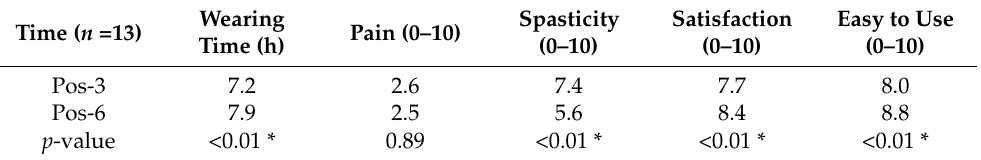
Table 4. Subjective reported wearing time, pain, spasticity, level of satisfaction, and ease of self-wear in the experimental